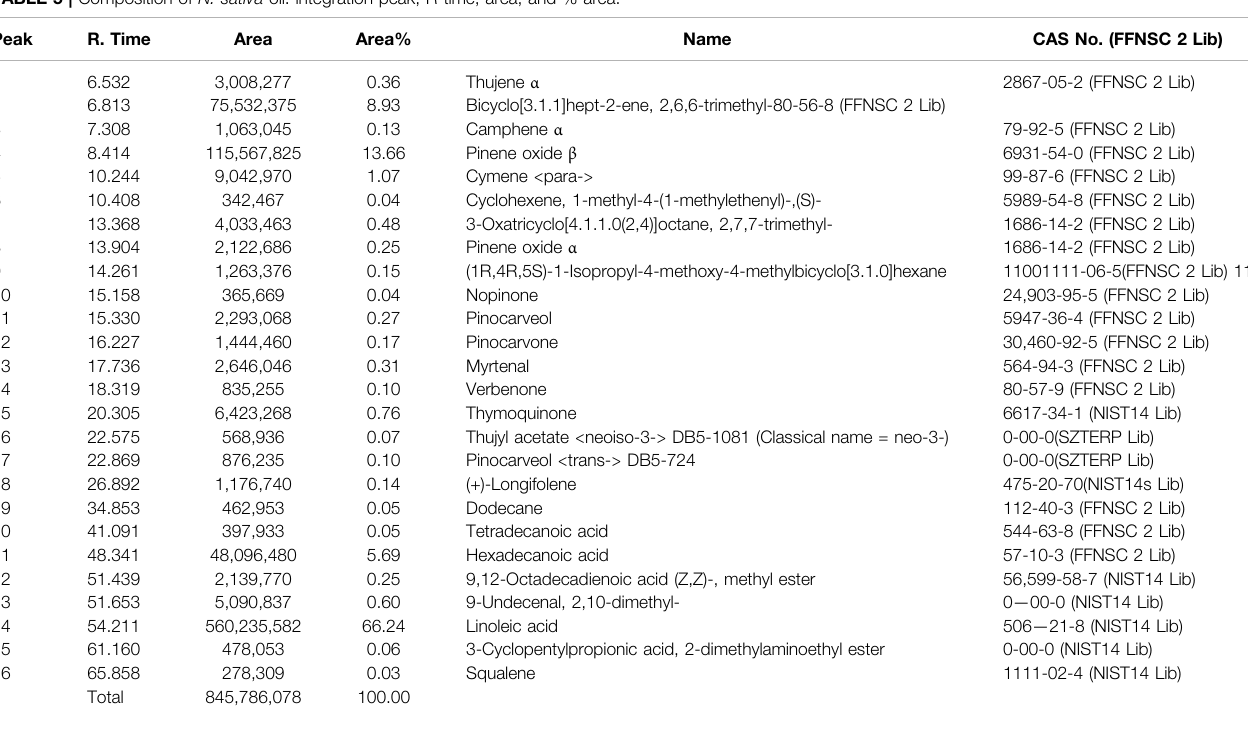
TABLE 5 | Composition of N. sativa oil: integration peak, R time, area, and % area. Peak R. Time